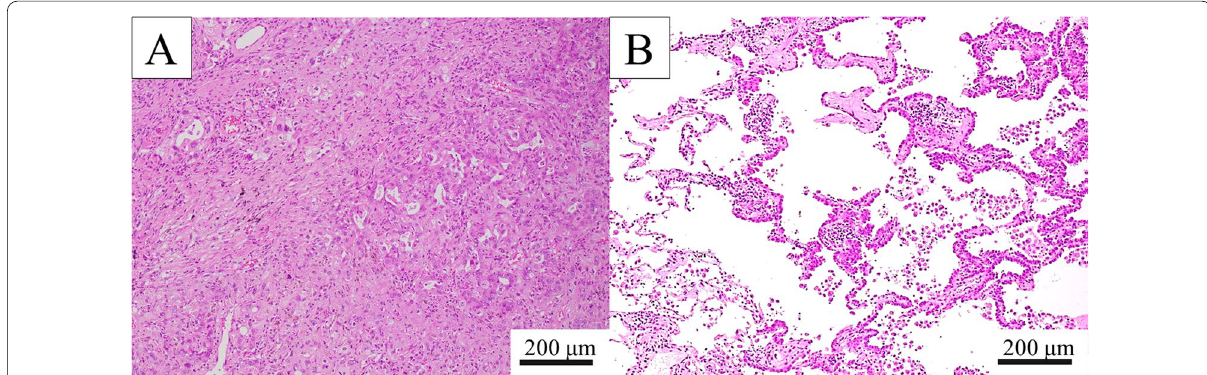
Fig. 2 Pathological findings. a Tumor cells proliferated with solid, papillary, and lepidic growth patterns in the right-upper lung adenocarcinoma (hematoxylin and eosin method, 100). b Adenocarcinoma in situ detected in the right-upper lung cavitary lesion (hematoxylin and eosin ×